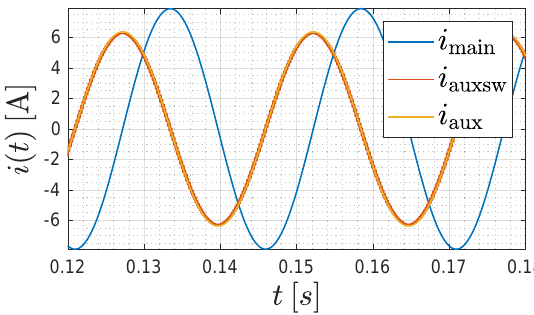
Figure 8. The averaging method for current phase advancing.